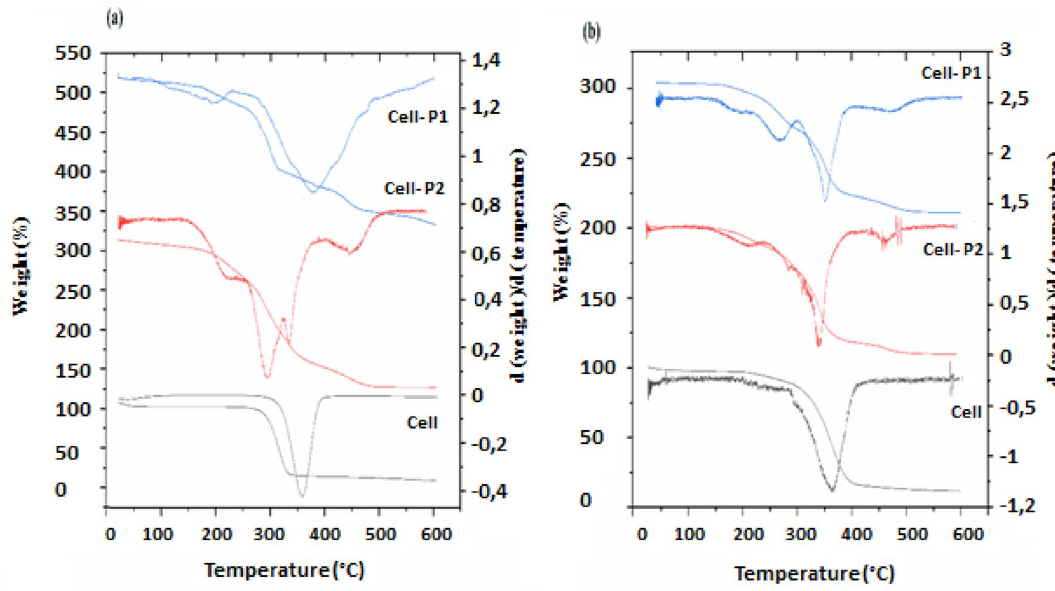
Figure 6. TGA/DTG thermograms for: ( a ) Cell-P 1 , Cell-P 2 , and cellulose, and ( b ) CA-P 1 , CA-P 2 , and CA.